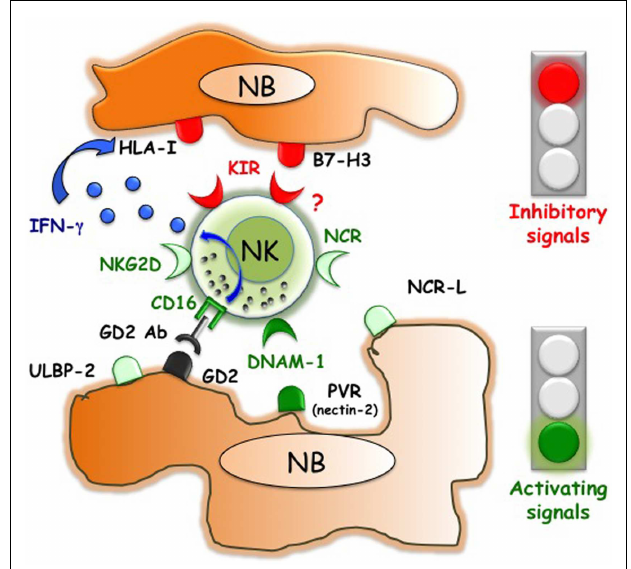
FIGURE 1 | Inhibitory and activating interactions between human NK cells and neuroblasts . NB express ligands that are recognized by NK receptors with activating or inhibitory function.While DNAM-1/PVR interactions play a pivotal role in triggering NK cell-mediated killing, B7-H3 dampens NK cell function. NB usually lack or express low, non-protective levels of HLA class I molecules. However, therapeutic approaches such as the in vivo administration of anti-GD2 Abs could induce not only ADCC of NB but also the release of INF- γ , which upregulates the expression of the ligands for inhibitory